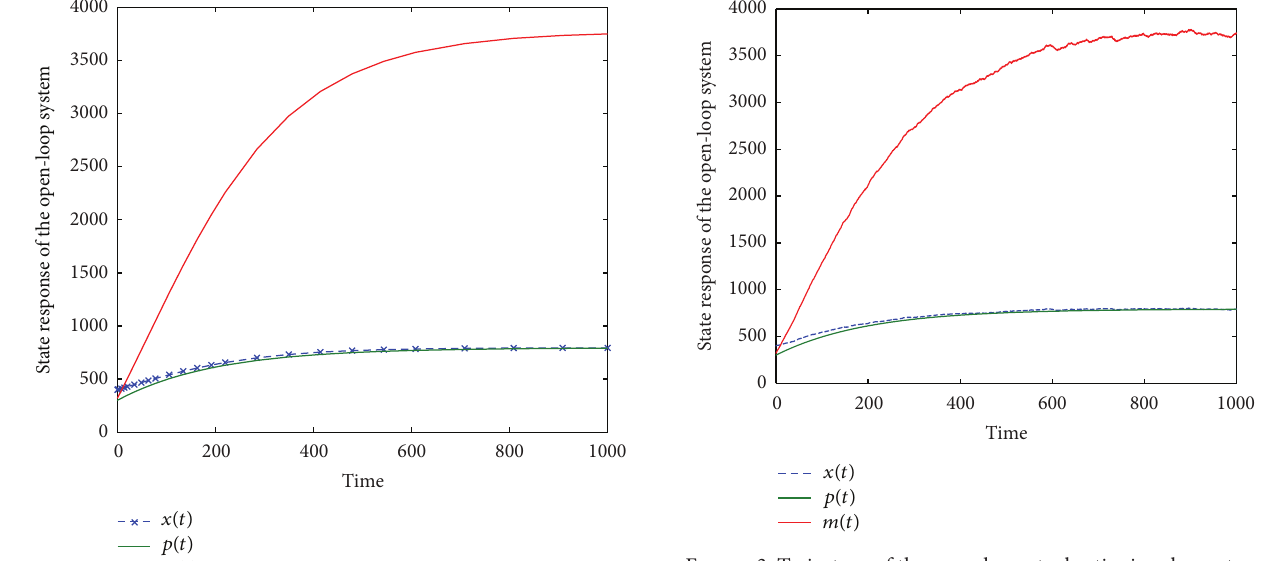
Figure 3: Trajectory of the open-loop stochastic singular system.